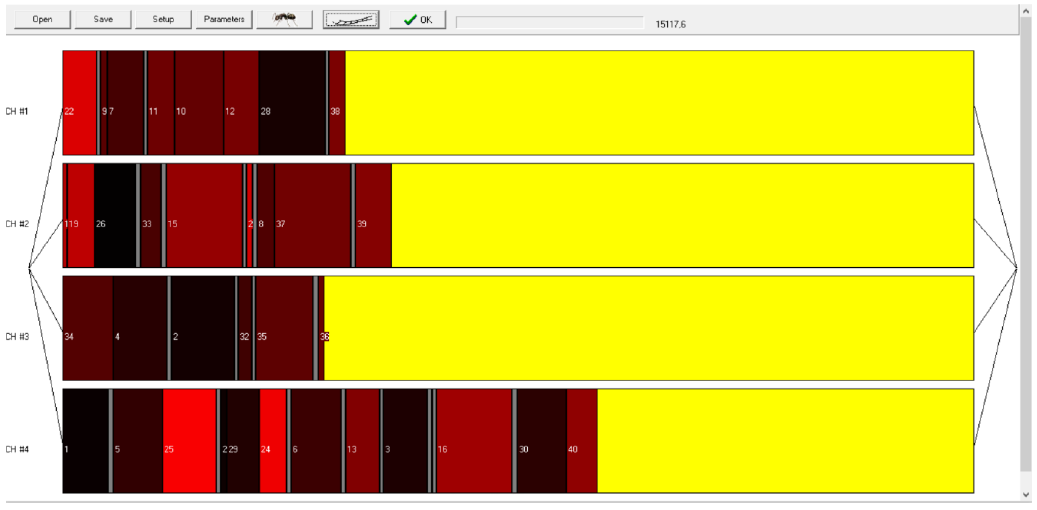
Figure 6. The result of the allocation for the parameters alpha = 0.6 and beta = 0.4. This was in line with the practical experience that most orders were allocated to the fourth